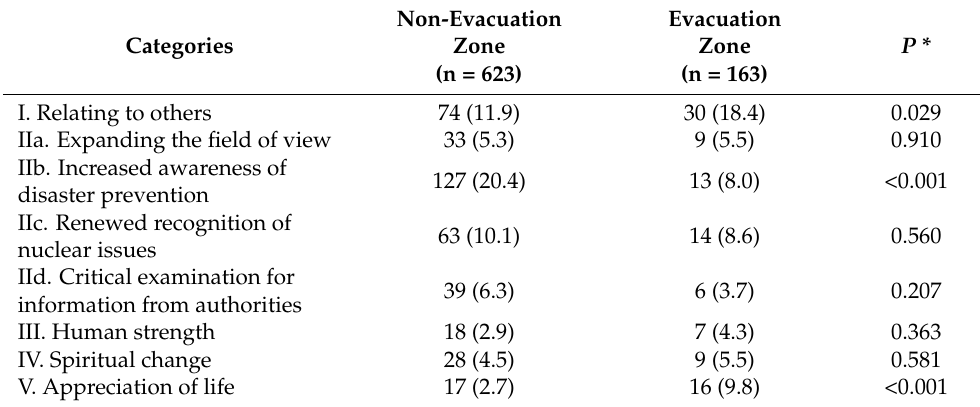
Table 3. Associations between the residential areas and the categories for PTG free descriptions.